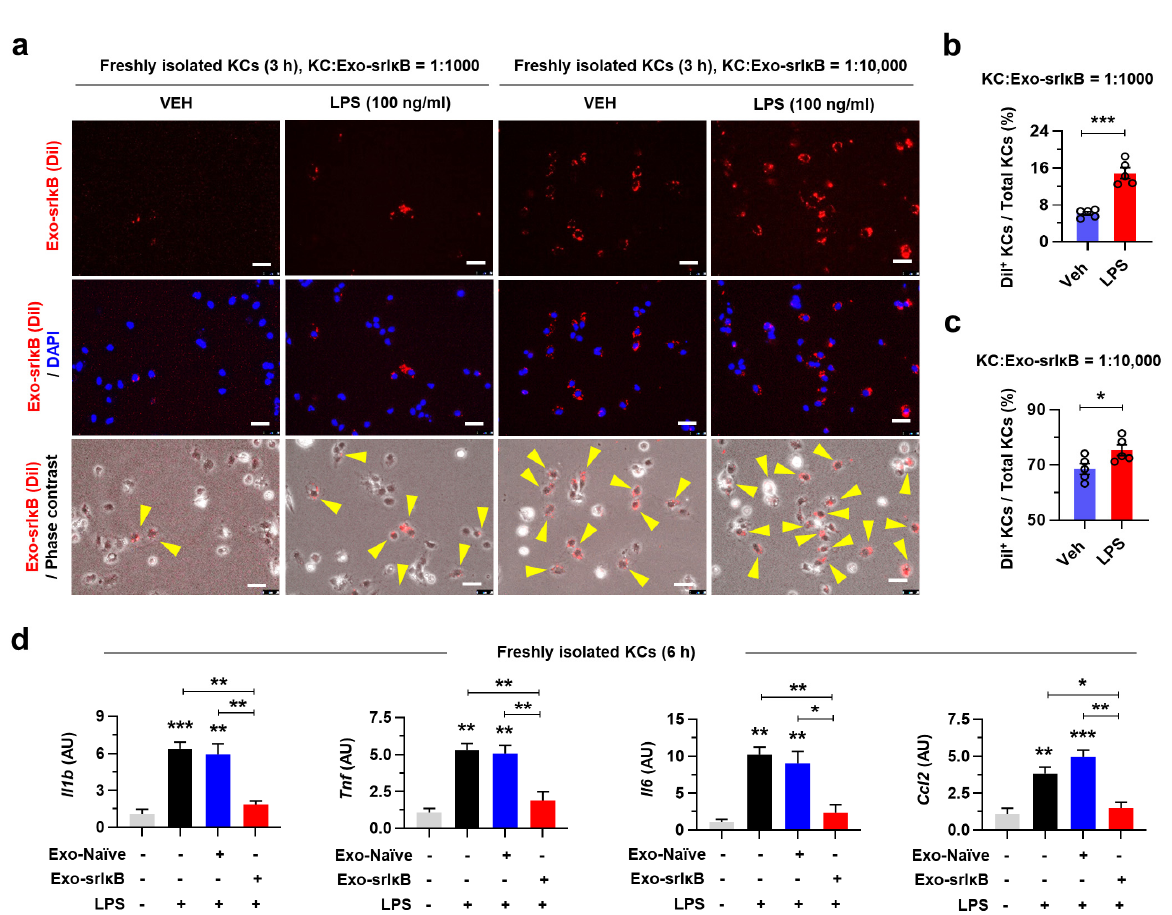
Figure 3. Exo-srI κ B suppresses LPS-induced inflammatory gene expression levels in isolated mouse KCs. ( a – c ) Indicated doses of DiI-labeled Exo-srI κ B were treated to isolated mouse KCs with vehicle (saline, VEH) or LPS (100 ng mL − 1 ) for 3 h ( n = 5 per group). ( a ) Representative pictures of cultured mouse KCs. Scale bars, 50 µ m. ( b , c ) The frequencies of DiI + KCs among total KCs. ( d ) Quanti- tative real-time polymerase chain reaction (qRT-PCR) analyses of isolated mouse KCs pretreated with control exosomes (Exo-Naïve) or Exo-srI κ B (KC:exosome = 1:10,000) for 3 h followed by LPS (100 ng mL − 1 ) for 6 h ( n = 3 per group). Data are presented as mean ± SEM. * p < 0.05, ** p < 0.01, *** p < 0.001. Data were analyzed by a two-tailed Student’s t -test or one-way analysis of variance (ANOVA) with Tukey’s multiple comparisons